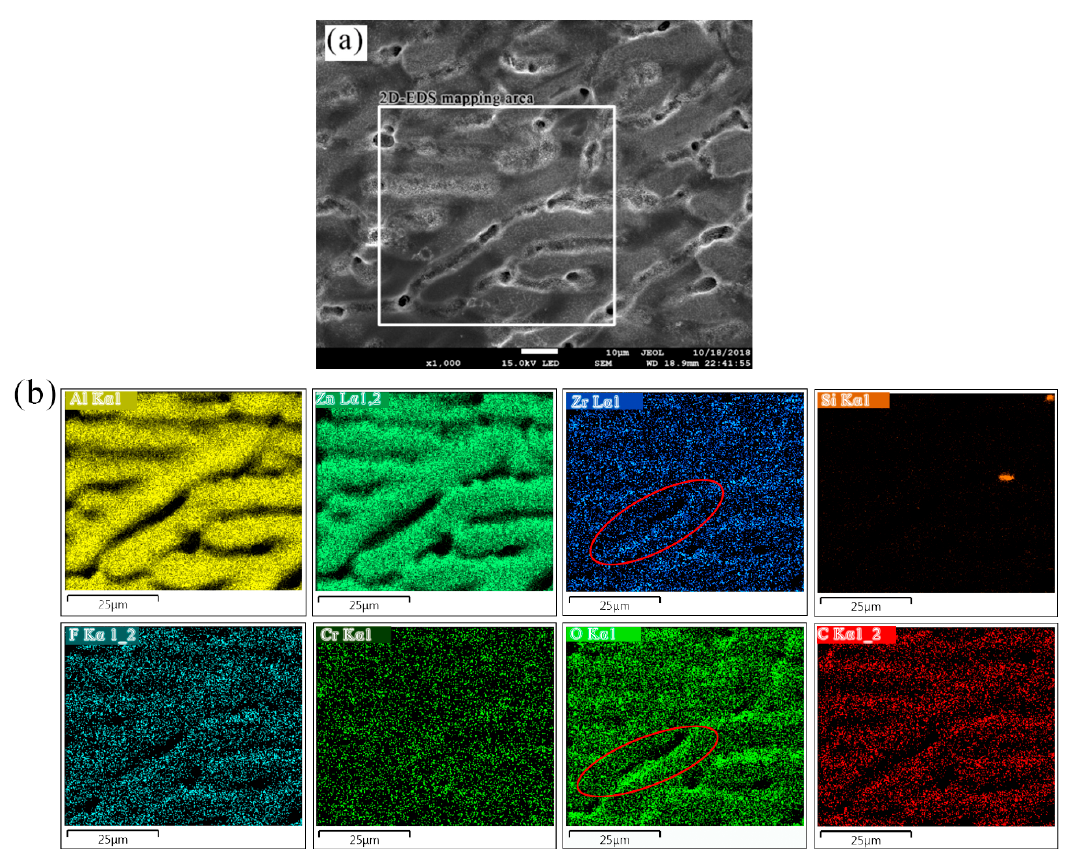
Figure 9. ( a ) SEM morphology of a 180 s formed TCC on Zn55Al and ( b ) 2D-EDS elemental maps of Al, Zn, Zr, Cr, F, Si, C and O performed over the area on the specimen marked with red dotted rectangle as indicated in Figure 9a.